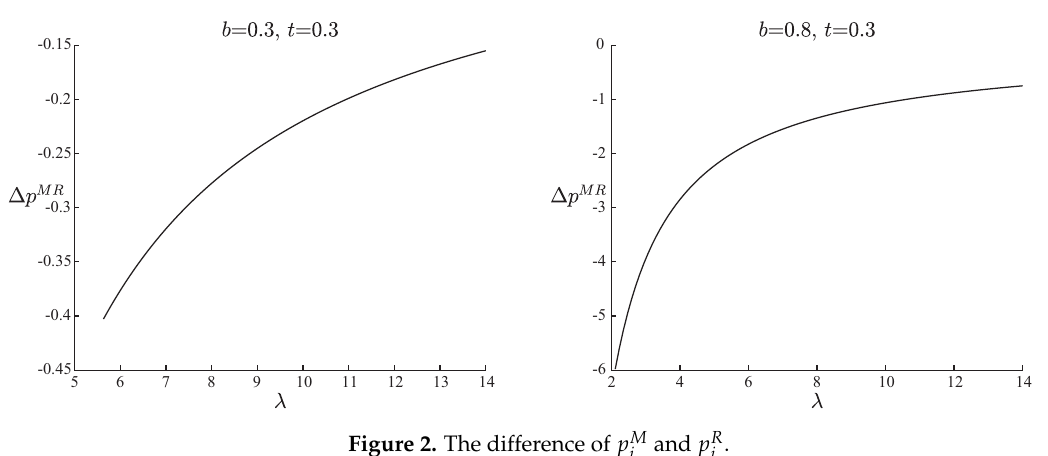
Figure 2. The difference of p M